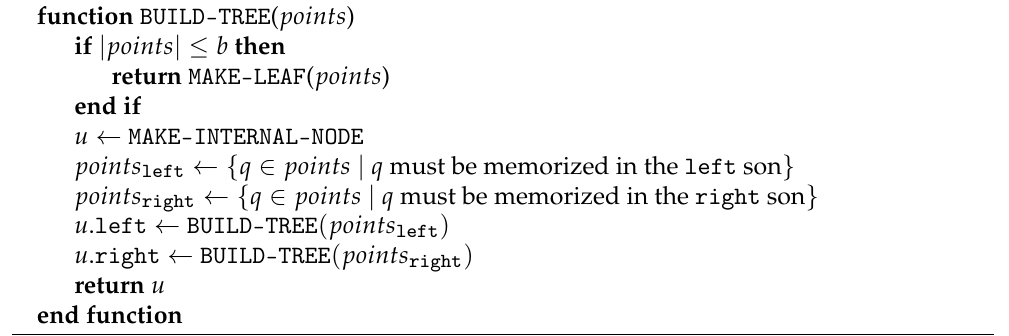
Algorithm 2 General tree